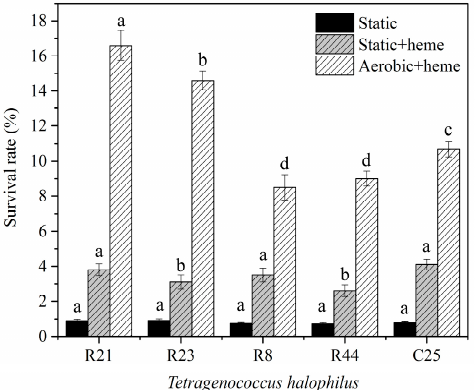
Figure 3. Hydrogen peroxide tolerance of T. halophilus strains under different conditions. Different lowercase letters indicate significant differences among individual groups ( p < 0.05).